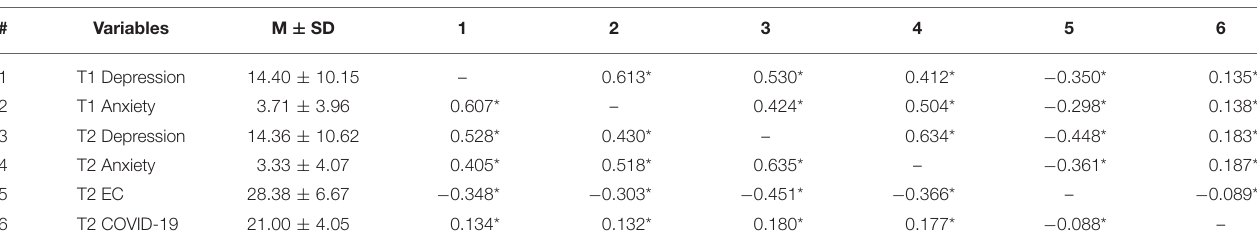
TABLE 2 | Means, standard deviations, and correlations among study variables ( n =